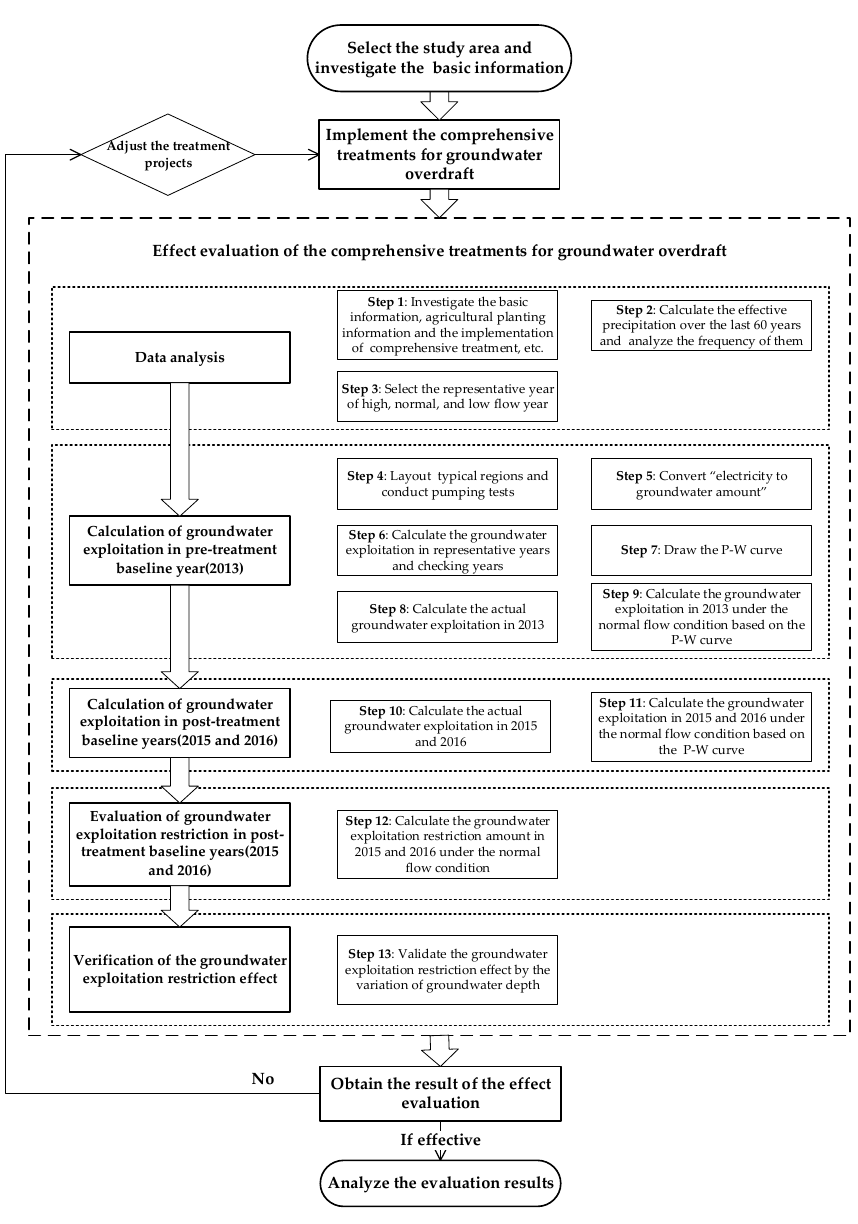
Figure 2. The overview of the study.